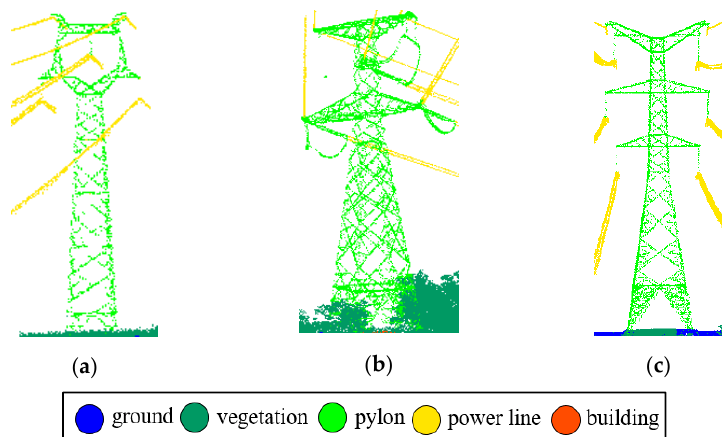
Figure 9. The pylons are colored by the true labels: ( a ) Pylon type in the training set; ( b ) pylon type-I in site II; ( c ) pylon type-III in site III.